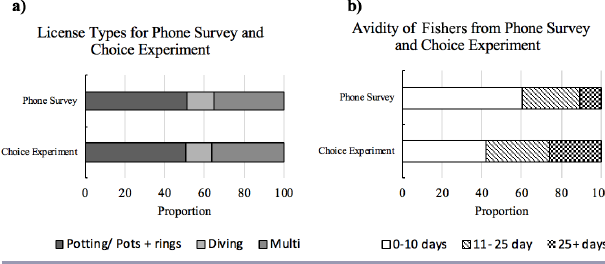
Fig. 3 . Distribution of a) fishing method by license type and b) avidity of the fishers who took part in the phone survey and the choice